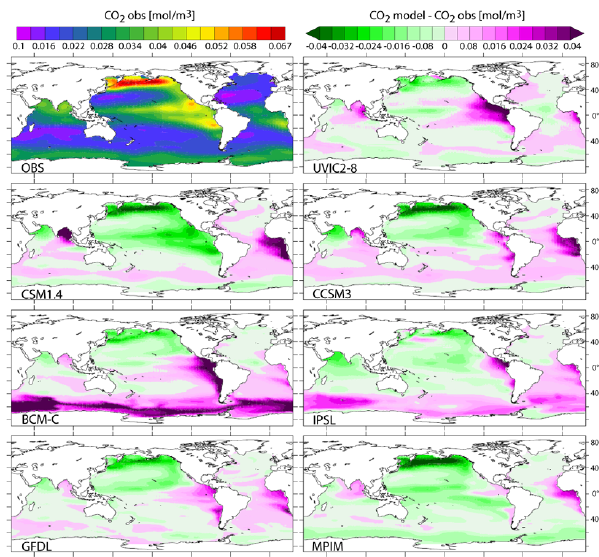
Fig. B2. CO 2 in the UML (100–600m depth average). Upper left: CO 2 as calculated from GLODAP alkalinity and DIC, WOA 09 temperature, salinity, phosphate and silicate. The other panels rep- resent the difference between observation-based and modeled dis- tributions (1990–1999 mean) of CO 2 .